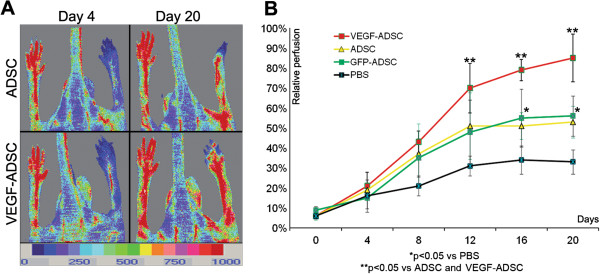
Reperfusion of murine ischemic limb after ADSC administration. A. Representative laser-doppler scans of subcutaneous blood flow in mice from “ADSC” and “VEGF-ADSC” groups obtained at days 4 and 20 after ischemia induction and cell transplantation. B. Dynamics of blood flow recovery in ischemic limbs within 20 days after intramuscular injection of ADSC, GFP-ADSC, VEGF-ADSC or PBS.